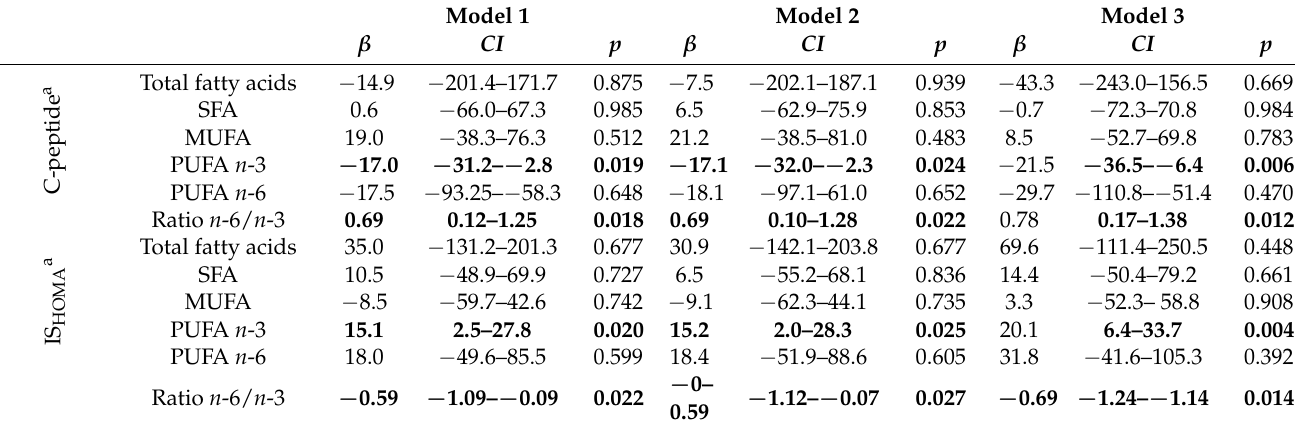
Table 1. Associations between C-peptide or IS HOMA and fatty acids classes are independent of BMI and leptin.